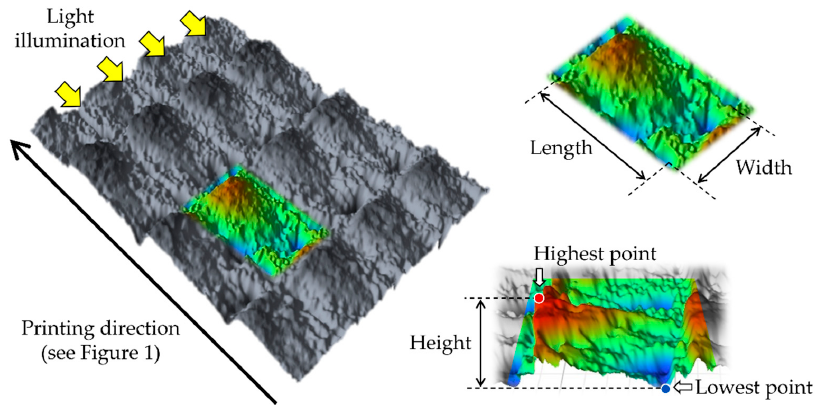
Figure 3. The measures for the size of the 3D microlayer structural unit.